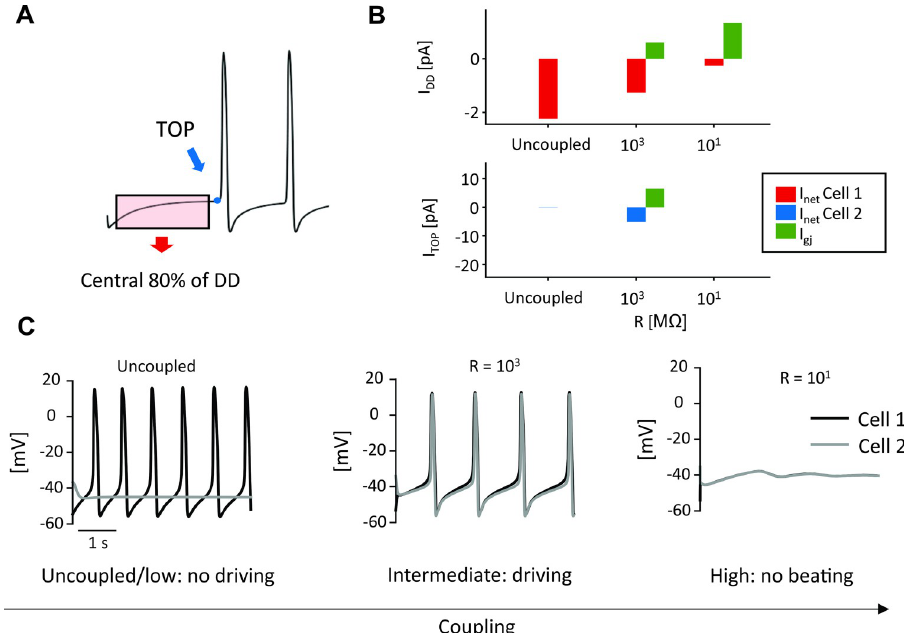
Fig 9. Coupling between a spontaneous cell and a dormant cell. (A) Average I net and I gj were extracted from the central 80% portion of the first occurrence of DD (from the beginning of the simulation to the first TOP); TOP I net and I gj were sampled at the time of the TOP. (B) I net and I gj trends during diastole (top) for Cell 1 (spontaneous) and at TOP (bottom) for Cell 2 (dormant) with respect to different degrees of cellular coupling. I gj is plotted in green for Cell 1 in both panels (the positive sign indicates an outward current, supplied to Cell 2). (C) Behavior of the two cells depending on coupling: both cells are beating periodically only for intermediate coupling